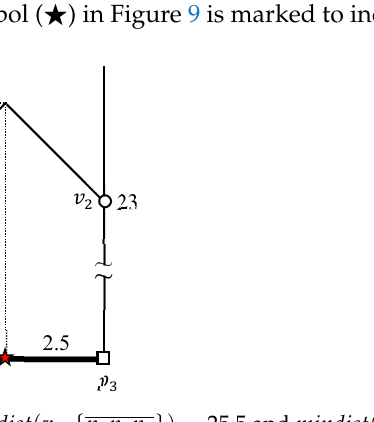
Figure 9. maxdist ( v 2 , { p 1 p 2 p 3 } ) = 25.5 and mindist ( v 2 , { p 1 p 2 p 3 } ) =